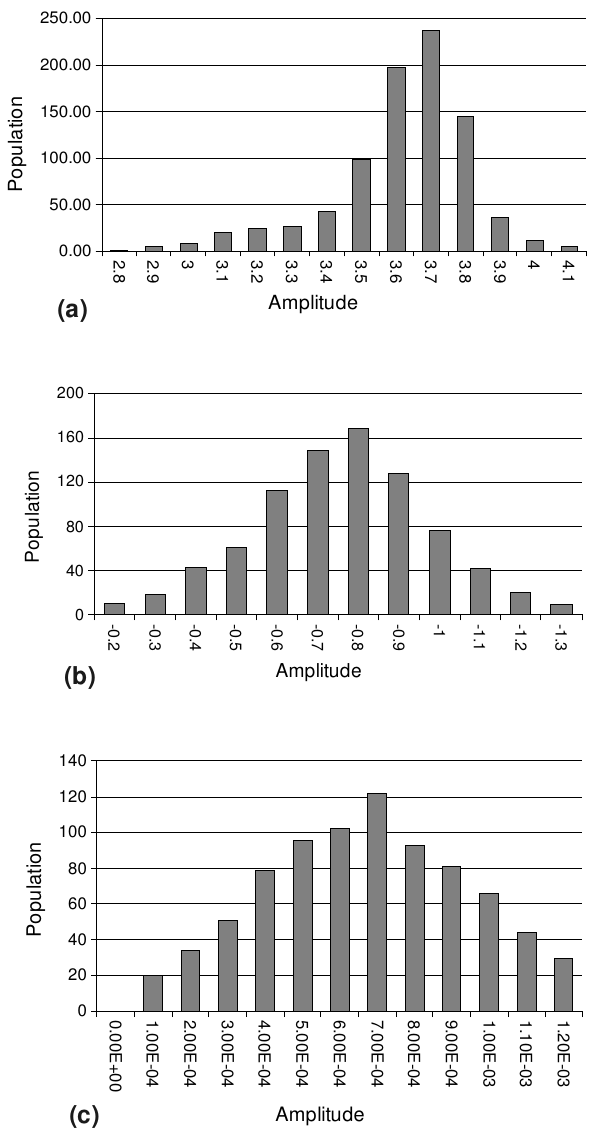
Fig. 4. Histograms of the peak amplitude of reflections picked from 900 traces from the seismic section (Fig. 1). (a) the seabed; (b) the multiple of the seabed (not shown on figure); and (c) the top of the turbidity layer. The shape of the histogram is indicative of the con- sistency of the reflection coefficient, the rugosity of the reflection surface in 3-D and the signal-to-noise